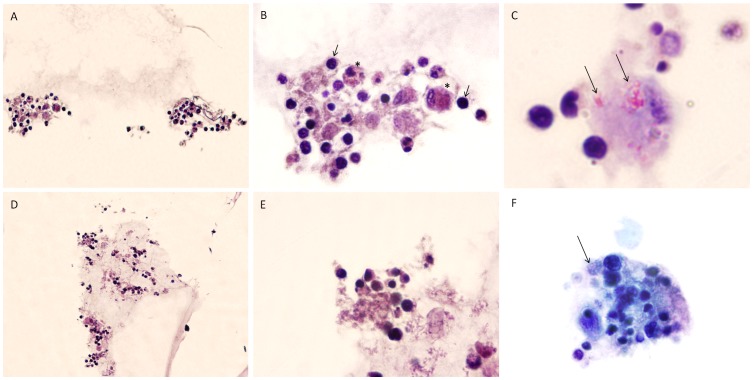
Morphological characterization of the cell populations recruited within in vitro- ovine granulomas.Primary ovine PBMCs (5x105) were seeded on an extracellular matrix and subsequently infected with the K10 reference strain (A, B and C) or with an ovine isolate of Map (2349/06-1) (D, E and F) at MOI (Bacteria:cells) 1:8. At 10 days p.i., the granuloma-like aggregates were harvested, processed for histopathology and stained with HE (A, B, D and E) and ZN stains (C and F). Original magnification in A and D  =  200X and in B, C, E and F  =  1000X. As shown in image B, macrophages (asterisk) and lymphocytes (arrows) were present in the granulomas. In images C and F, acid-fast bacilli (arrows) were observed within macrophages by ZN staining.